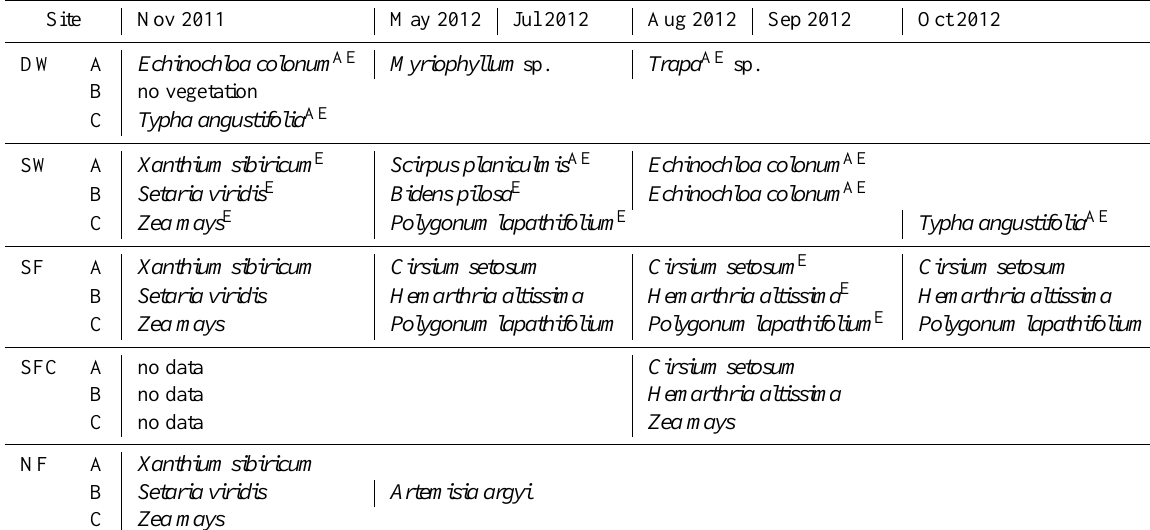
Table 1. Dominant plant species at each plot in different months. DW: deep water site, SW: shallow water site, SF: seasonally flooded site, SFC: “control site” for seasonally flooded site, NF: non-flooded site. A, B and C indicate sample plot with different vegetation. Species with aerenchyma are denoted A ; species that are emergent are denoted E